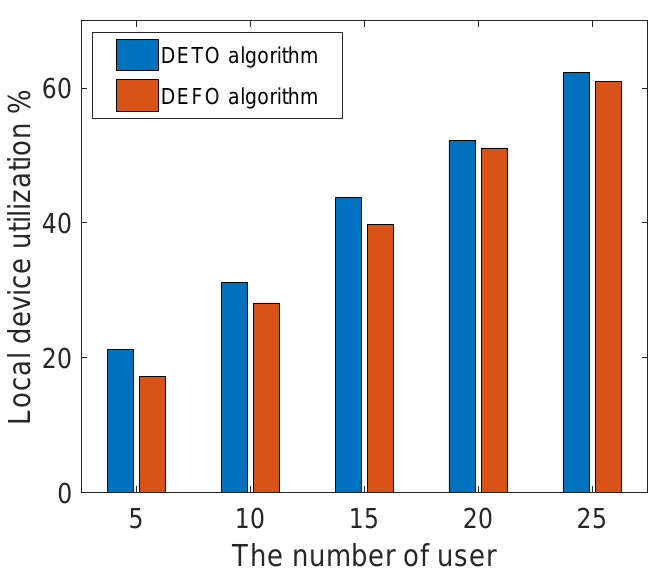
Figure 8. Edge server utilization.